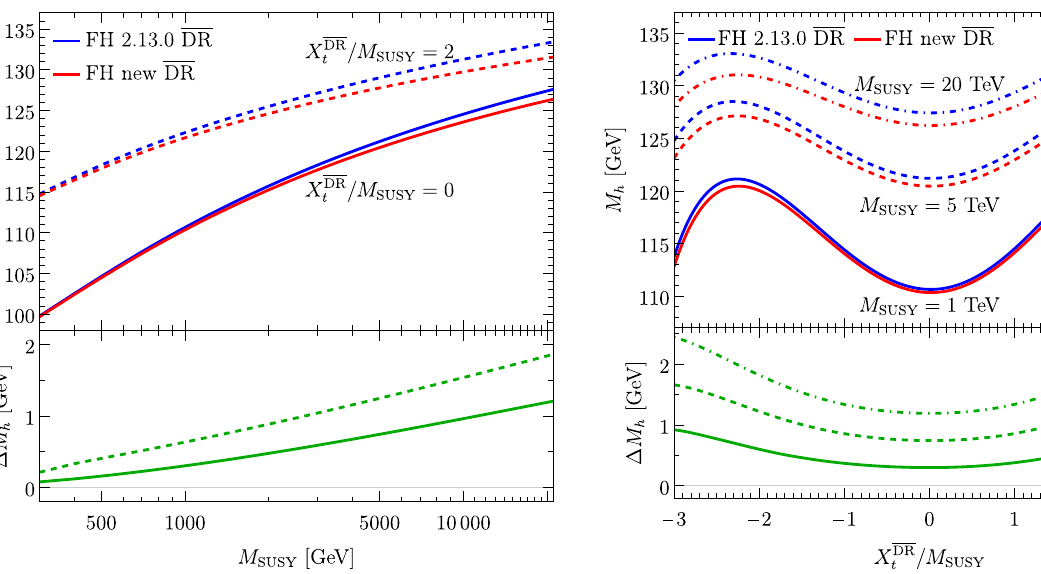
ing stop mixing and X DR t / M SUSY = 2. Right: Prediction for M h as function of X DR t / M SUSY for M SUSY = 1 TeV (solid), M SUSY = 5 TeV (dashed) and M SUSY = 20 TeV (dot-dashed). In the bottom pan- els, the difference between the blue and red curves is shown ( Δ M h = M h ( FH 2.13.0 DR ) − M h ( FH new DR )